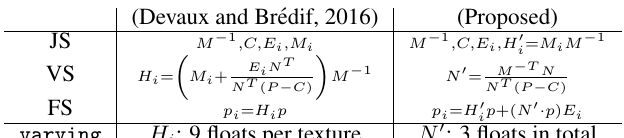
Figure 3. (a) The photograph is texturing the fully built tower, although the building was still in construction when the photograph was taken. (b) On the left, the bright area corresponds to sky pixels texturing a building that was not built yet when the photograph was taken.